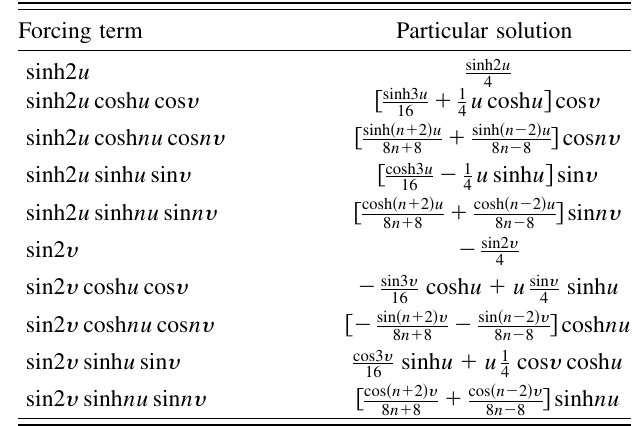
TABLE II. The terms related to the longitudinal components in the right-hand sides of Eqs. (C4) are proportional to the functions in the Forcing term column. The corresponding par- ticular solutions are reported in the other